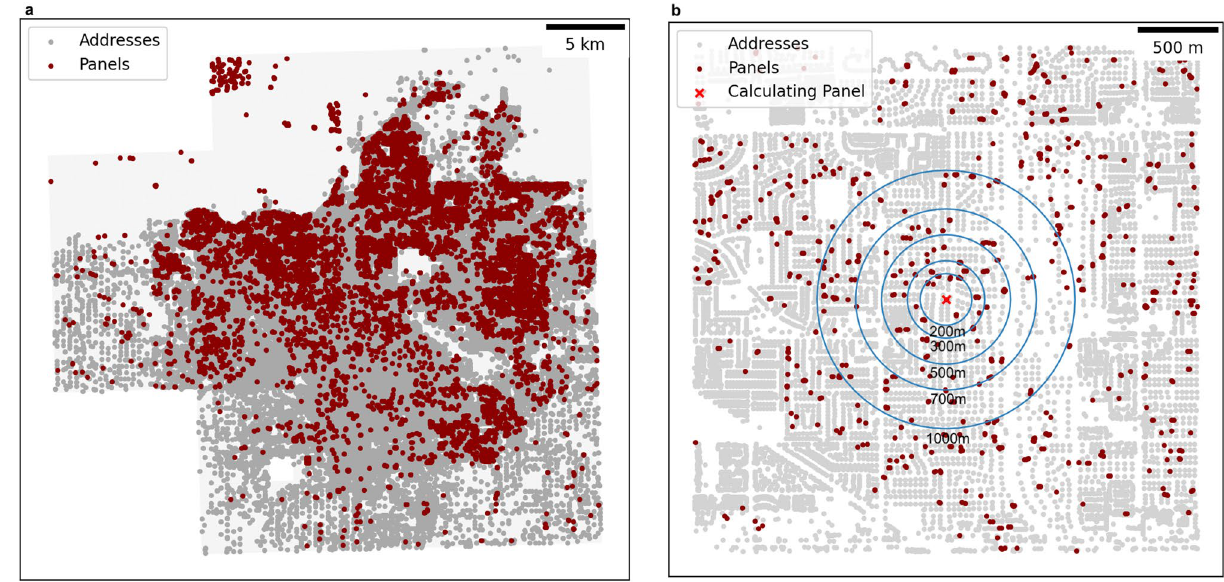
Figure 1. Geolocations of solar panels and addresses in Fresno included in the analysis . In panel (a), light grey boxes indicate bounds of the aerial images in which the solar panel geolocations are marked. Each address is marked with a grey dot, and each panel geolocation is marked by a red dot. Geolocations of solar panels and bounding boxes of the aerial images these data were derived from are taken from Bradbury, et al. (2016), address data for the city of Fresno is made publicly available by the County of Fresno13. Panel (b) is a close-up illustrating the panel density calculation process, the red ‘x’ indicates the panel around which panel density is calculated, with several example radii provided in